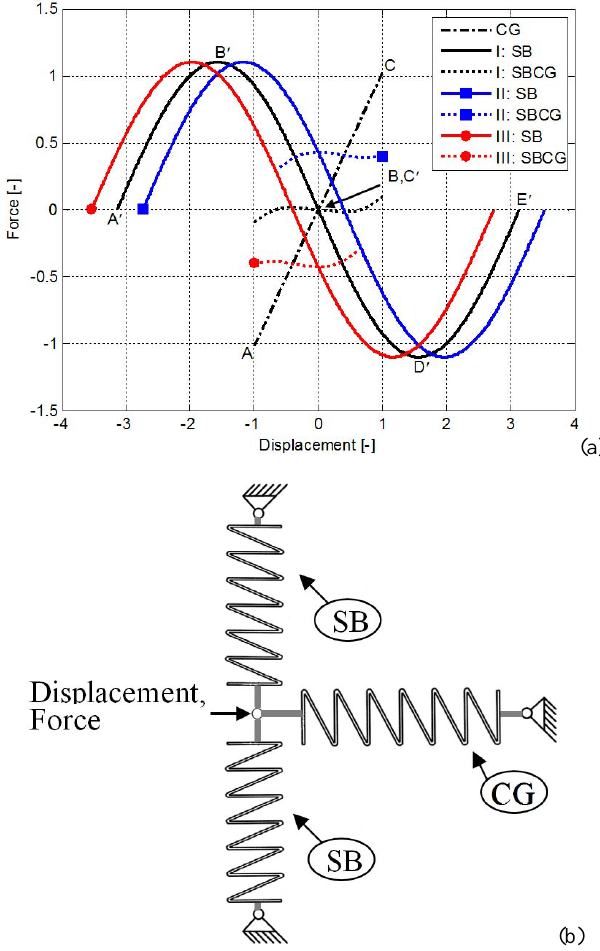
Figure 3. (a) The force-displacement curve and (b) the correspond- ing configuration of a typical bi-stable mechanism (static balancer, SB) and the compliant grasper (CG) as a pin-pin bi-stable linear compression spring mechanism and a linear extension spring re- spectively. The shown configuration in (b) corresponds with posi- tion B of (a) . (a) also shows the di ff erent cases (I–III) of zero sti ff - ness with zero (black lines), constant positive (blue lines (cid:4) ) and constant negative actuation force (red lines • ). Force-displacement behaviors accomplished by positioning the center of the static bal- ancer (SB) relative to the compliant grasper (CG). Positioning the unstable equilibrium (C 0 ) can be performed by